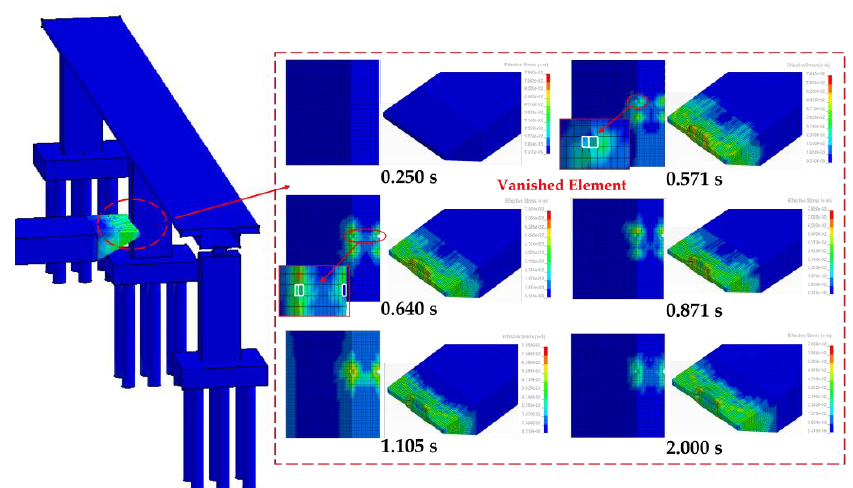
Figure 9. Barge – whole bridge stress nephograms. Figure 9. Barge– whole bridge stress nephograms.